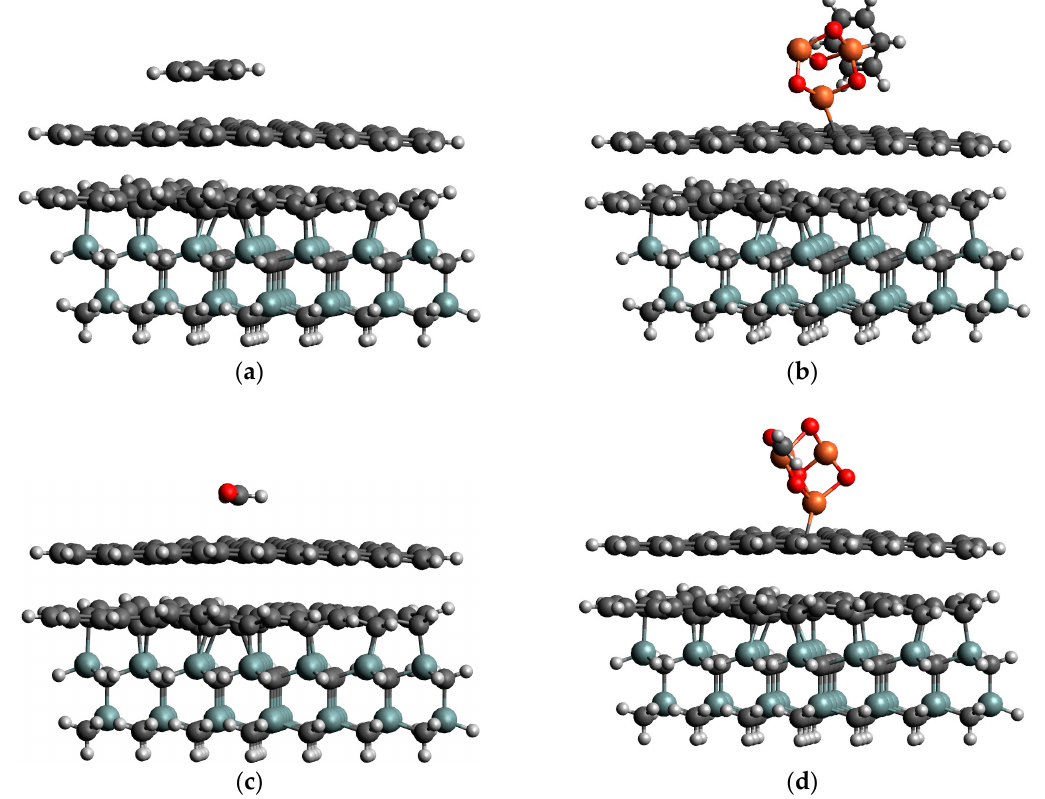
Figure 4. Optimized adsorption configurations of benzene on ( a ) PEG and ( b ) DEG. Preferred adsorption geometries of formaldehyde on PEG and DEG are presented as ( c ) and ( d ).